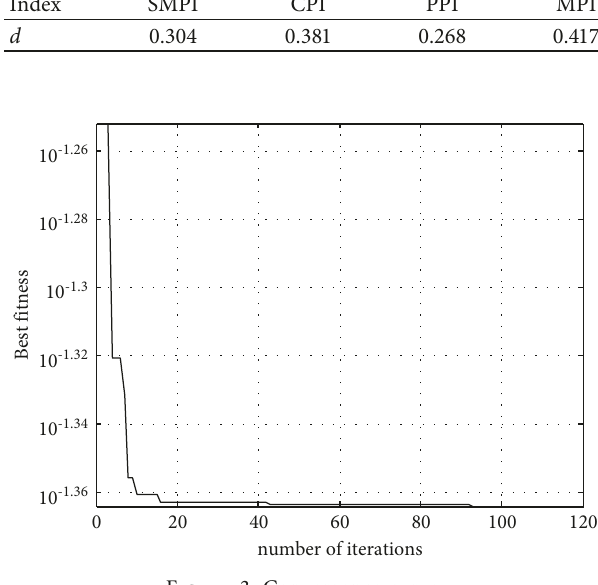
Figure 3: Convergence curve.